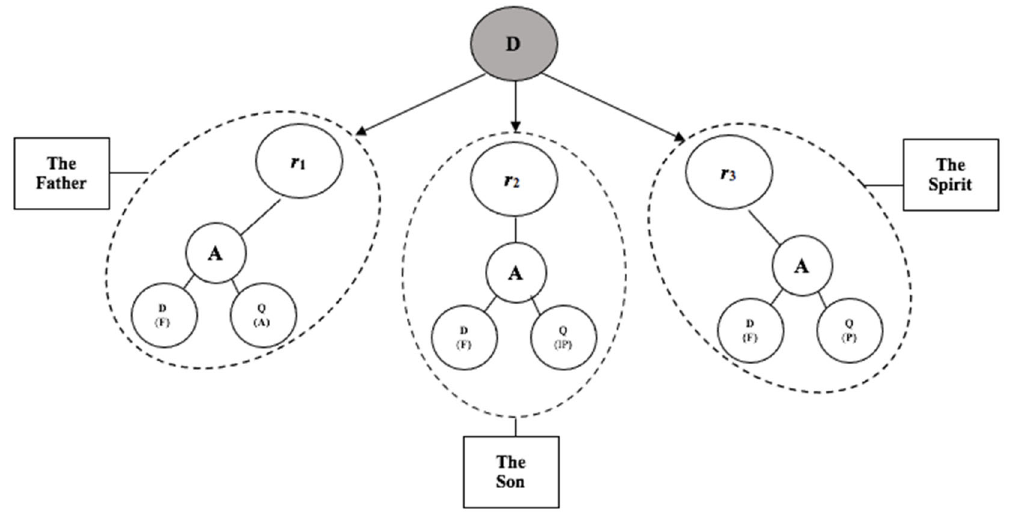
Figure 9. Divinity ‐ Aspects